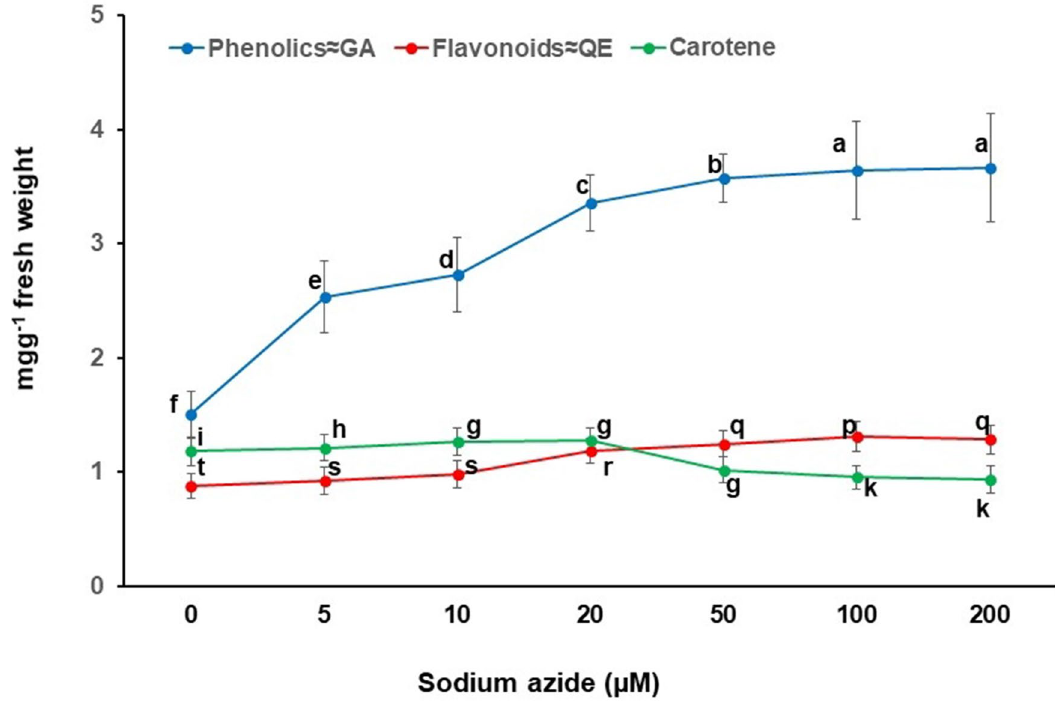
Figure 4. Graded doses of sodium azide significantly ( p < 0.001) affect contents of phenolics, flavonoids and carotene in callus extract of Nigella sativa . Vertical bars refer to ± standard deviation and histograms bearing the different alphabets in a series of data are significantly different from each other (Tukey’s HSD activation/elevation of antioxidant enzymes (peroxidase, polyphenol oxidase and catalase) and non-enzymatic secondary metabolites 57 . Our investigations also corroborate activity enhancement of antioxidant enzymes (Fig. 3) as well as non-enzymatic antioxidant metabolite contents, especially polyphenols (Fig. 4) due to sodium azide treatment to NS callus. Further, NS responds positively to sodium azide stress treatment in comparison to NaCl stress treatment (60 mM) that decreases phenolic acids and flavonoid content 58 . Previously, the salinity stress due to NaCl administration deprived the phenolic and flavonoid content in NS 58 . Our investigation also